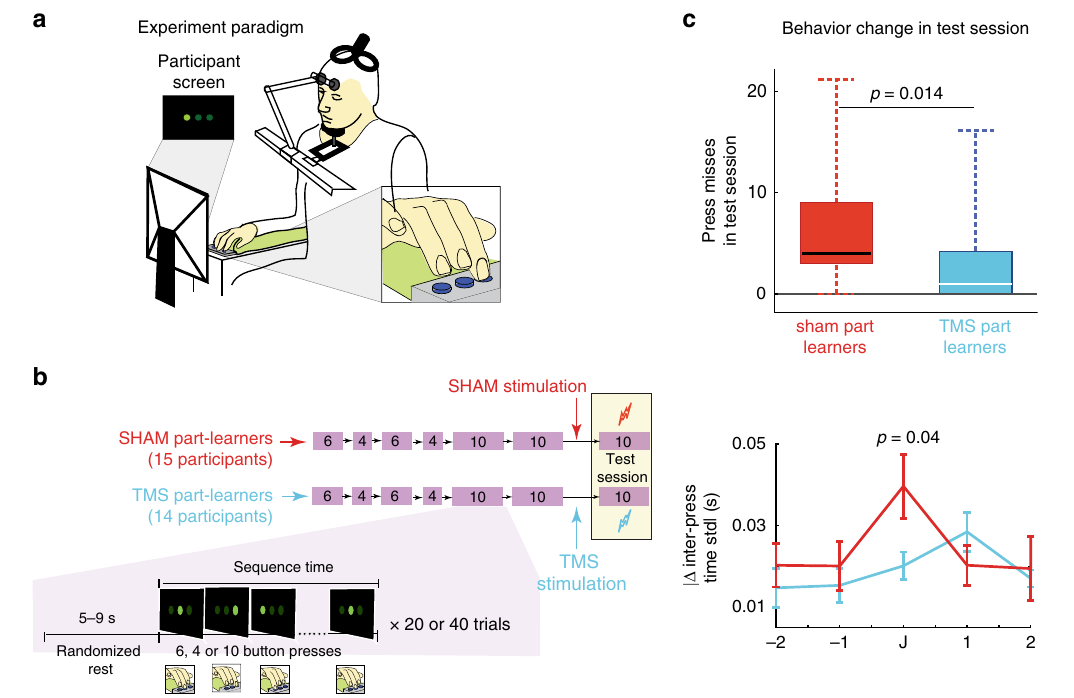
Fig. 3 Experiment 3: a All participants participated as part learners. They pressed a button pad as in Experiment 2, but in a sitting position. b They trained on the fi rst six and then next four buttons in the sequence, followed by two training sessions on the entire 10-button sequence, again as in Experiment 2. Half of the participants (TMS part learners) then were stimulated with rTMS to their dACC, and the other half (SHAM part learners) experienced SHAM stimulations for the same period. c The number of press misses are shown in the top panel with boxplots for the SHAM part learners (red plot) and TMS part learners (cyan data). On each box of the boxplot, the line within the box shows the median, the edges of the box are the 25th and 75th percentiles of the data, and the whiskers show the range of the data points. The bottom panel shows the absolute change in the inter-press time standard deviation (STD) near the junction in the anxiety test session. Error bars show standard error. The similarity of plots in Figs. 2c and 3c shows rTMS to the dACC attenuates the effects of anxiety on part learners, making them similar to single learners. All error bars represent standard error. All p values represent two-sample tests. We checked for the normality of the datasets using the Shapiro – Wilk test before each comparison. To get the p values, a t -test was used for comparisons when the data groups were normal, and a Wilcoxon rank-sum test were used when one or both of the datasets were non-normal (see text for